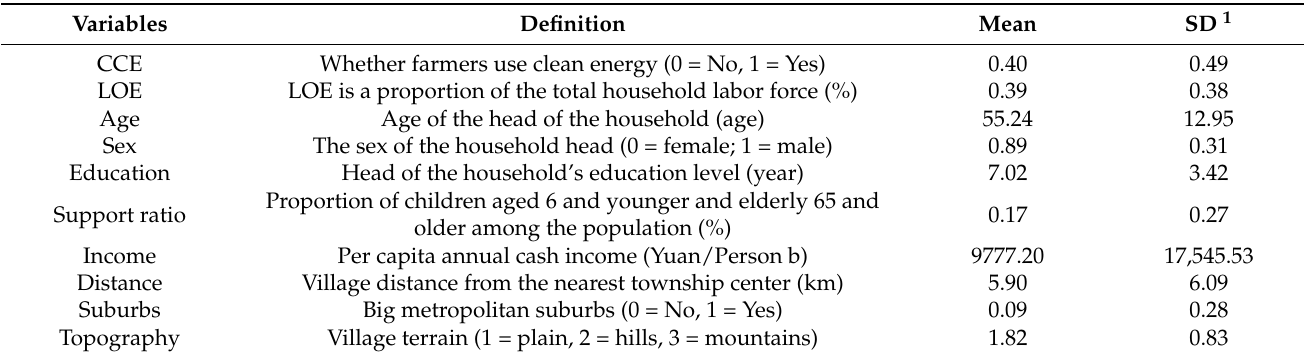
Table 1. Variable definition and descriptive statistics